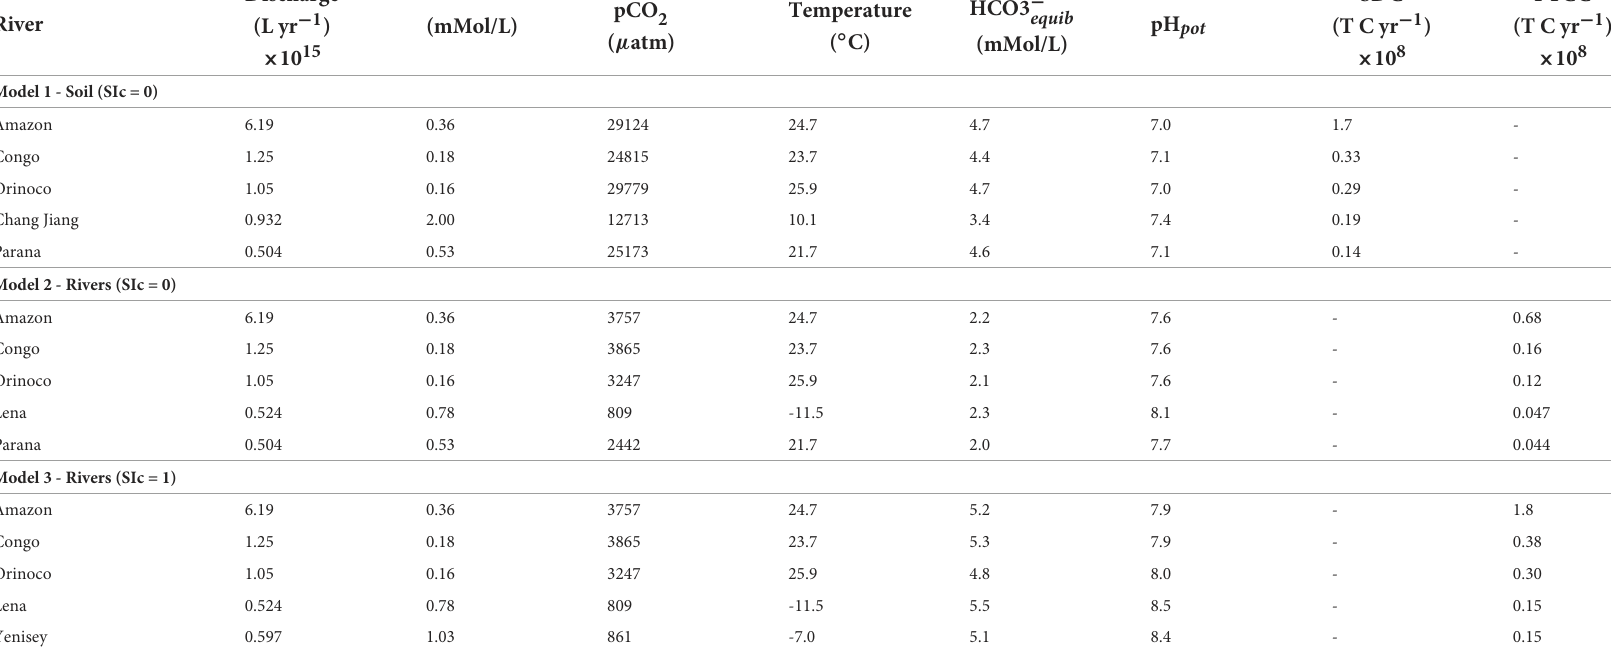
TABLE 1 Top 5 river basins from each model simulation by SDC (Model 1) and PTCC (Model 2 and 3). River